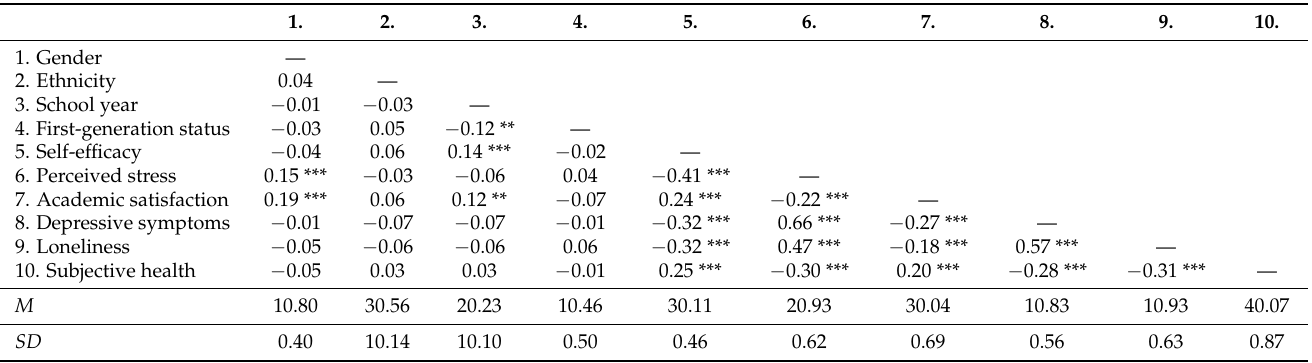
Table 1. Means, Standard Deviations (SDs), and Intercorrelations among Study Variables ( N = 693).